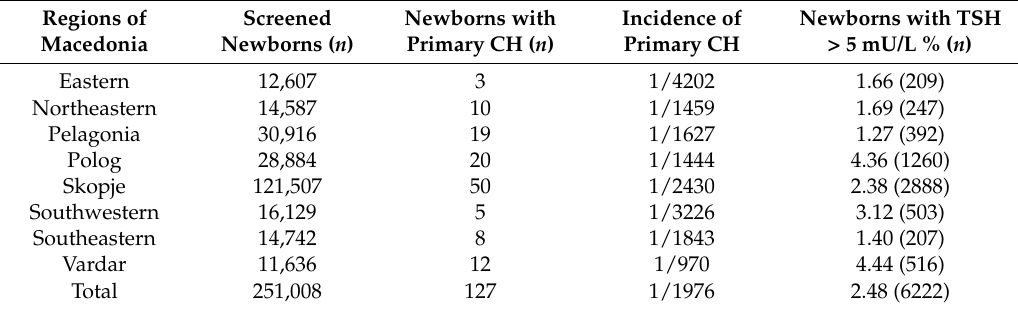
Table 1. Regional variation in CH incidence and percentage of newborns with whole blood TSH > 5 mIU/L, between 2002 and 2015.